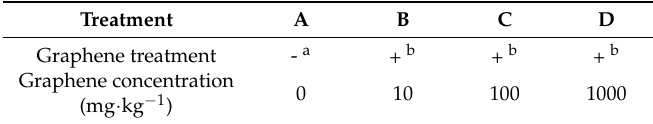
Table 2. The experimental layout. Each of the treatments below was determined after 7, 15, 30, 60, or 90